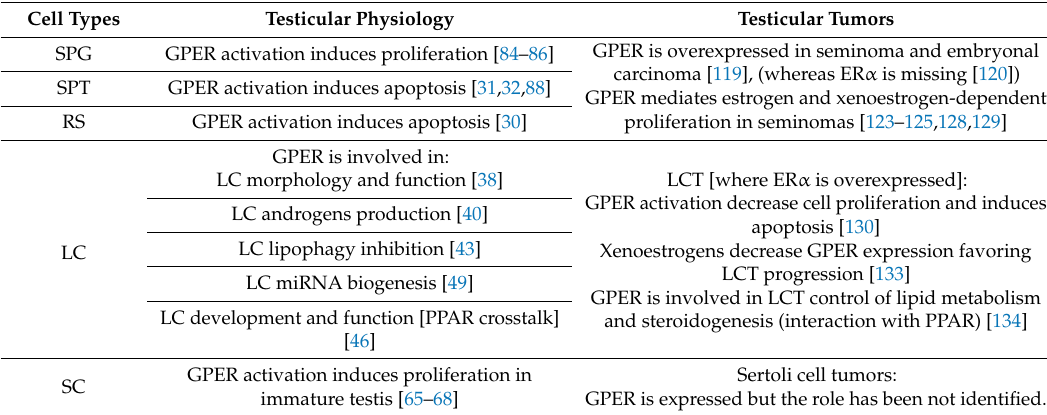
Participation of GPER in testicular physiology in main cell types and changes in testicular